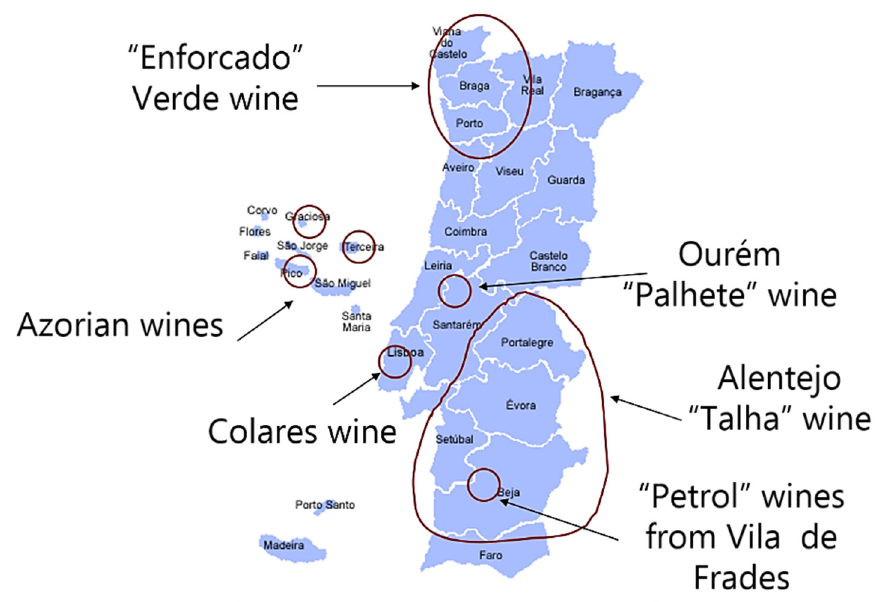
Figure 1. Examples of historical wines and their distribution across Portuguese territory.